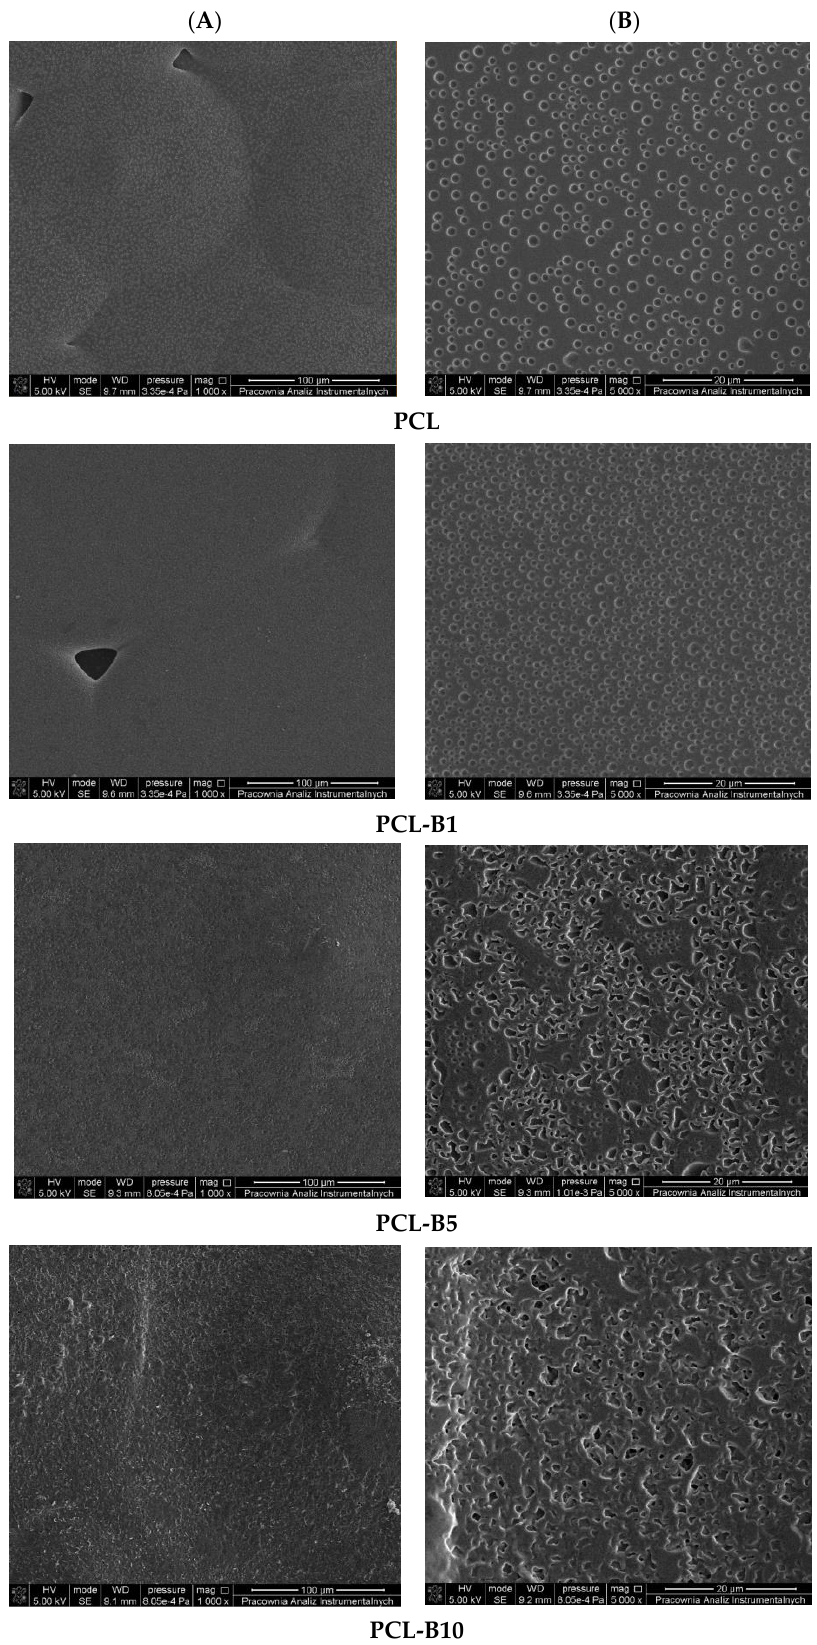
Figure 3. SEM analysis of surface of PCL and PCL with birch tar (PCL-B1–PCL-B10) materials, magnifications of 1000× ( A ) and 5000× ( B ).